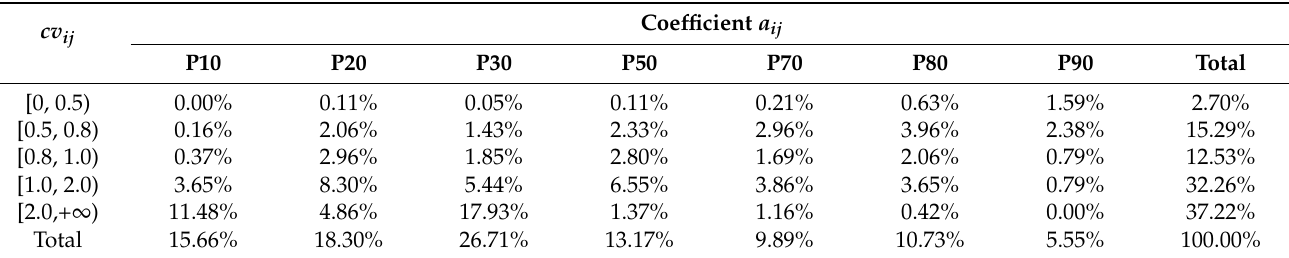
Table 2. Coefficients of variation (NBS method).